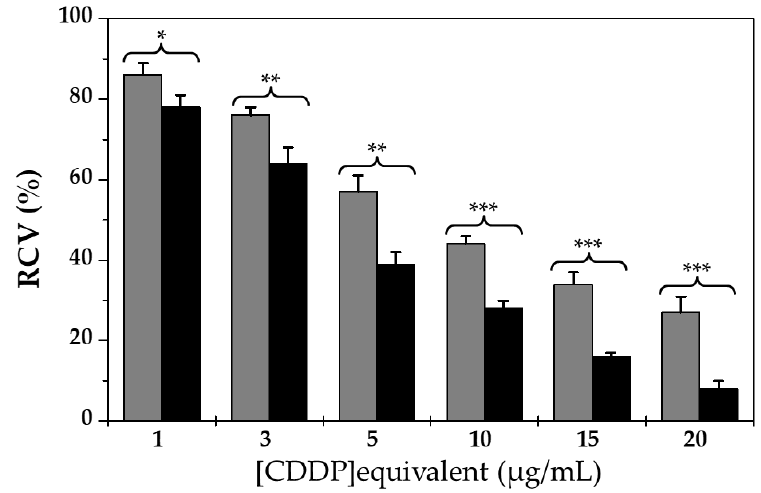
Figure 9. In-vitro cytotoxicity (RCV, %) of CDDP-loaded ( γ -Fe 2 O 3 /PLGA)/CS NPs (black column) and free CDDP (light grey column) in human lung adenocarcinoma A-549 cells, after 72 h of exposure to a wide range of NP concentrations (up to 20 µ g/mL equivalent CDDP concentration). The statistical Student’s t-test, considering 95% confidence interval, was significant (* p < 0.05) or very significant (** p < 0.01, *** p < 0.001), compared with the free CDDP-treated group. Complementary in-vitro tests will help in providing clear evidence of the successful delivery of CDDP to tumour cells, and the real possibilities of these (core/shell)/shell NPs against lung cancer. For instance, the apoptosis assay involving annexin V/propidium iodide staining, the crystal violet staining experiment determining viability of cultured